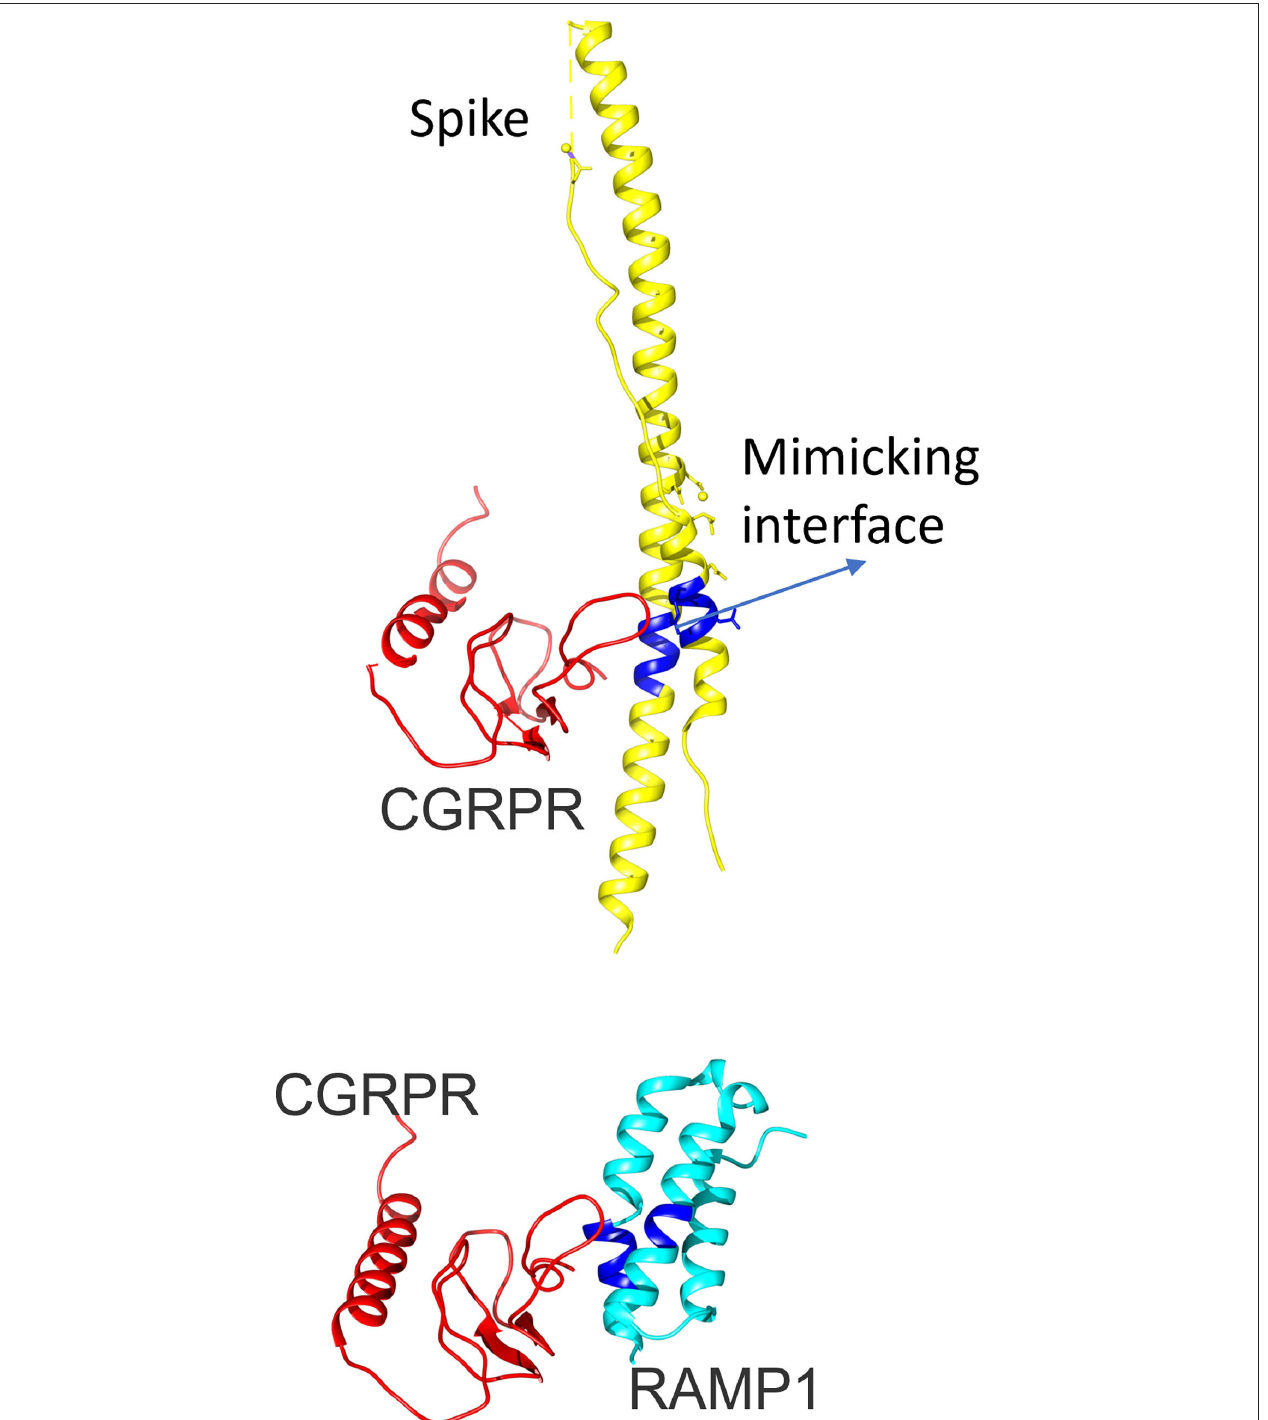
FIGURE 1 | The 3D configuration of calcitonin gene-related peptide-receptor activity modifying protein 1 (CGRP-RAMP1) heterodimer and severe acute respiratory syndrome coronavirus 2 (SARS-CoV-2) spike protein. The upper panel shows the 3D configuration of the CGRP receptor (red) and SARS-CoV-2 spike protein (yellow). RAMP1 is added in the bottom figure in turquoise (CGRP-RAMP1 heterodimer, PDB ID: 3n7p, chains B and F). The mimicking interface with spike protein is highlighted with blue color. CGRP, Calcitonin gene-related peptide; RAMP1, Receptor activity modifying protein 1; SARS-CoV-2, severe acute respiratory syndrome coronavirus 2.